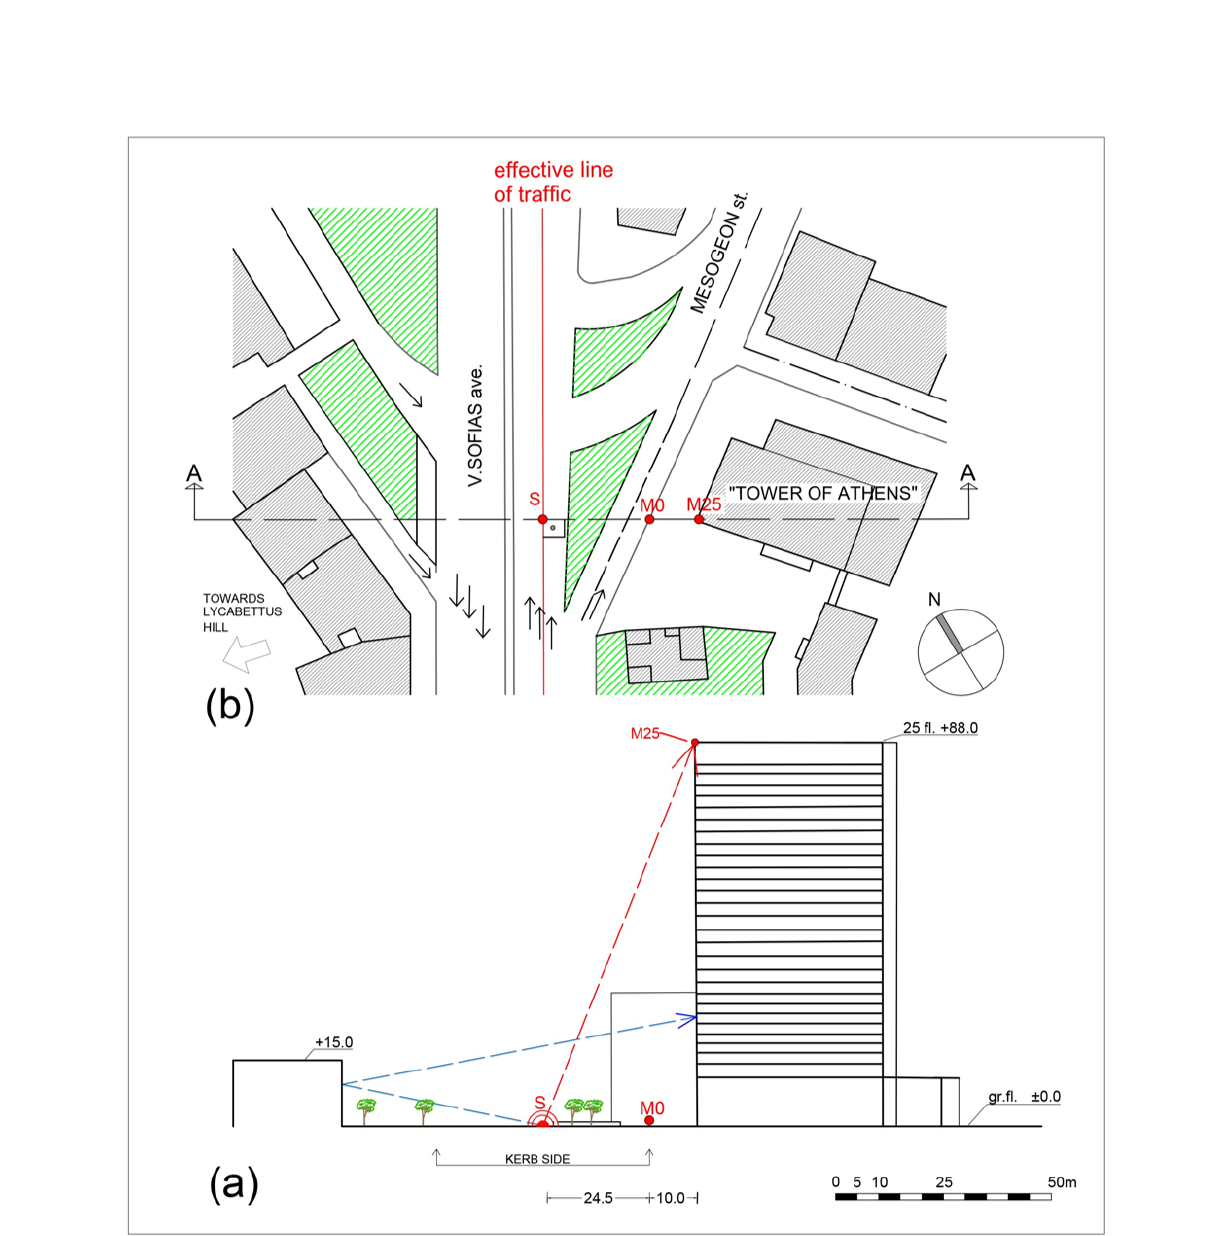
Figure 9: (a) Section and (b) plan of the “Tower of Athens”. S: sound source, M0:reference point, — : direct sound, — : reflected sound